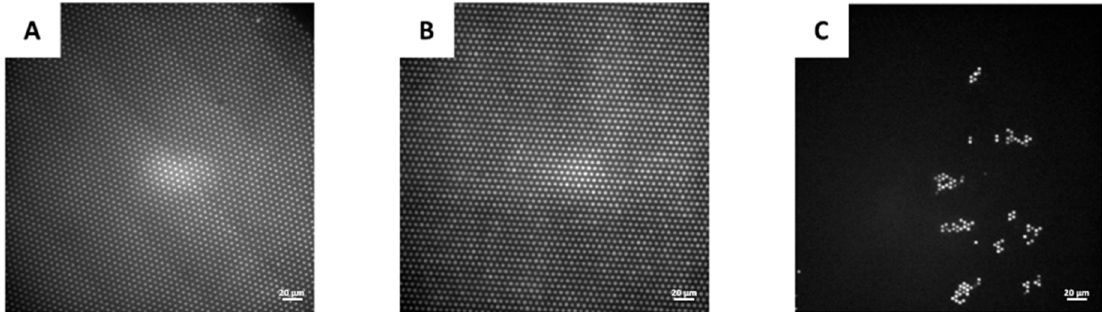
Figure 9. Fluorescence microscopy images of sealing an aqueous fluorescein solution in microwells with 40× magnification. ( A ) Sealing efficiency of nearly 100% in HIH microwells, fabricated through the proposed fabrication procedure (Procedure VII). ( B ) Sealing efficiency of nearly 100% in HIH microwells, fabricated through the conventional dry lift-off procedure. ( C ) Sealing efficiency of 3.79% in microwells, fabricated through molding without plasma etching (Procedure I), in the absence of fluoroalkylsilane.